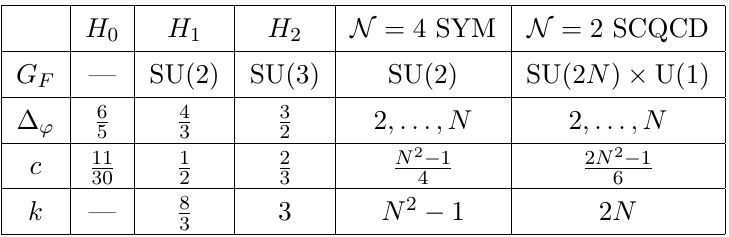
Table 1 . N = 2 theories that will appear in the discussion of our